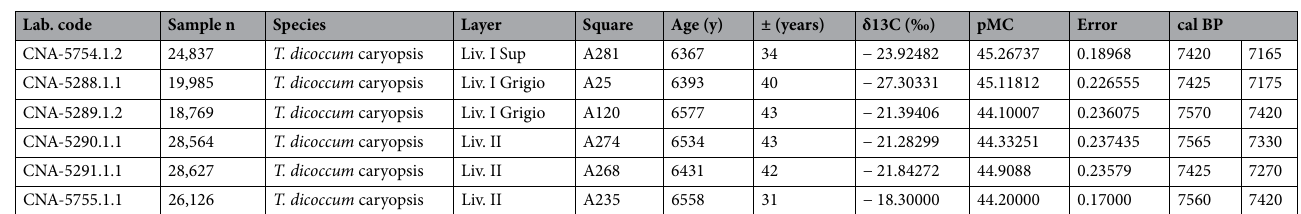
Table 1. New radiocarbon dates on charred emmer wheat caryopsis from La